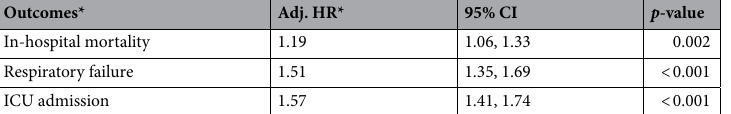
Table 4. Association of history of diabetes to the different outcomes of interest (time-to-event analysis). *Individual univariate multiple Cox proportional hazards regression analysis with independent variable diabetes adjusted for age group, sex, smoking history, hypertension, chronic cardiac disease, chronic kidney disease, chronic respiratory disease, chronic neurologic disease, chronic liver disease, and